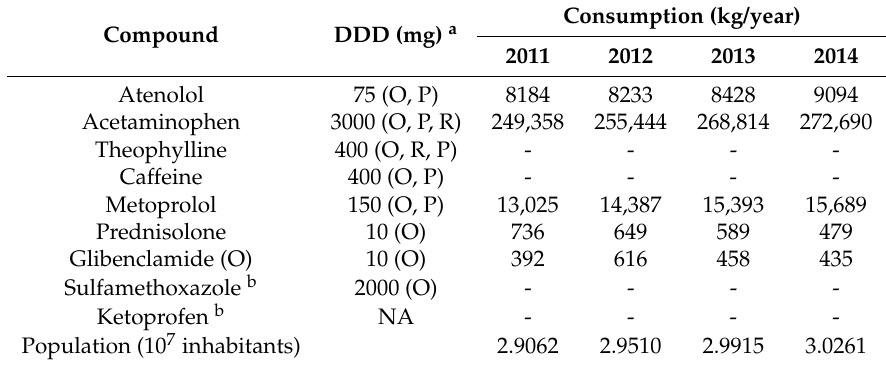
Table 1. Defined daily doses (DDD) and the consumption of the selected pharmaceuticals in Malaysia (MOH 2014).